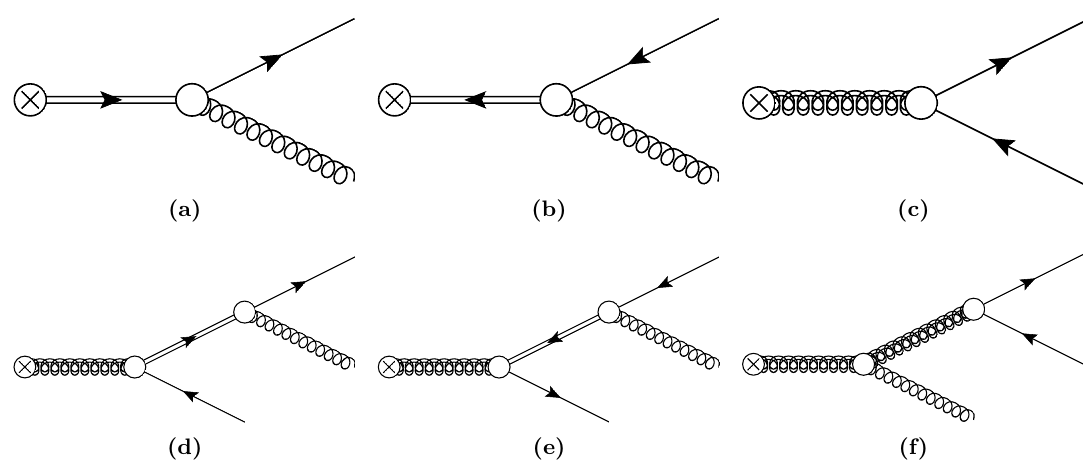
Figure 2. Diagrammatic representation of the expansion of the fields in (3.5). The top row is O ( g 0 ) : (a) represents χ 1 from (3.13), (b) ¯ χ 1 from (3.12), and (c) is a genuine new contribution due to the NMGF, namely F µ, 1 from (3.9). The bottom row is O ( g 2 ) , and are all terms of F µ, 2 from (3.10): 0 (d) and (e) represent the first line while (f) collectively represents the second line in (3.10).